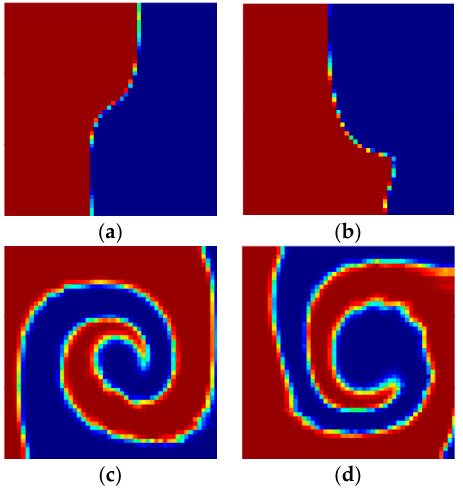
Figure 9. ( a , c ) are the distribution of coarse grain concentration on the outlet with 1 and 10 cycles shown in Figure 8a and d, and ( C ) are 0.9882 and 0.8413; ( b , d ) are the distribution of coarse grain concentration on the outlet of SHM (Figure 10) with 1 and 10 cycles, and ( C ) are 0.9883 and 0.8446.